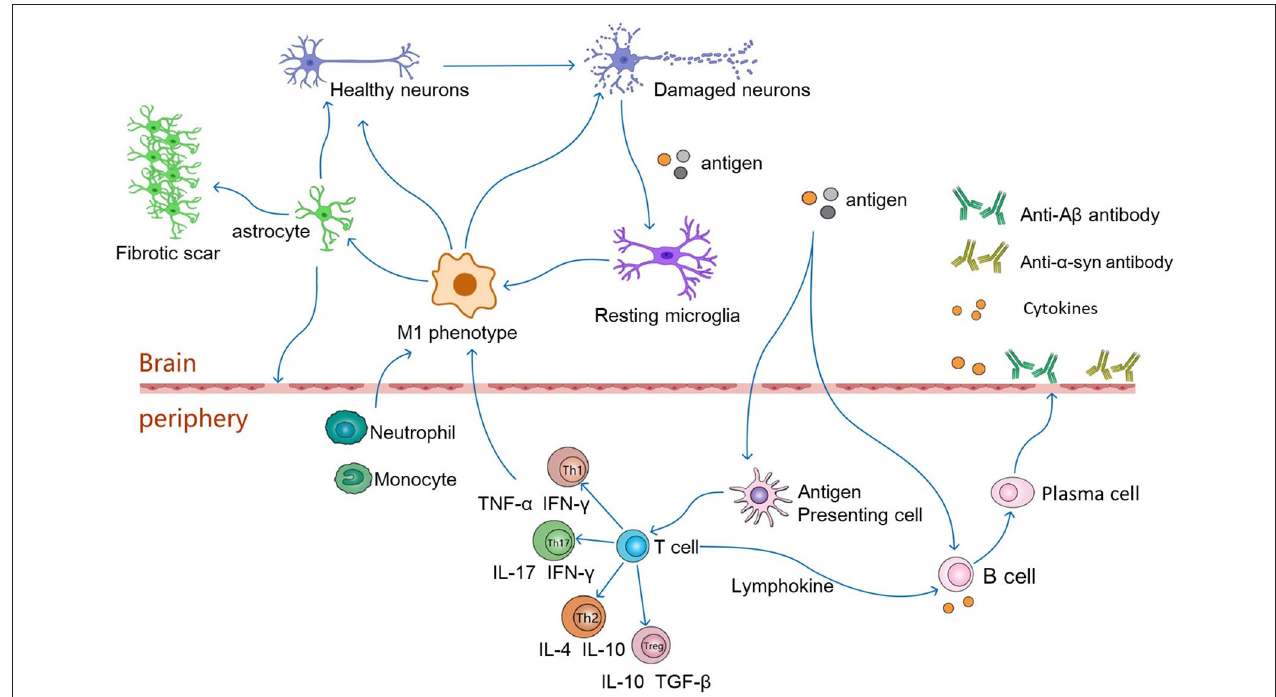
FIGURE 2 | In pathological conditions, damaged neurons release autoantigens to activate resting microglia, which differentiate into the pro-inflammatory phenotype of M1. The M1 phenotype microglia secrete pro-inflammatory factors(IL-6, TNF- α , IFN- γ ) to activate astrocytes, which induce the activation of A1 phenotype astrocytes. Reactive astrocytes contribute to the formation of glial scarring. It also leads to destruction of the BBB, which in turn leads to infiltration of CNS by peripheral immune cells. Antigens may enter peripheral lymphoid tissue, where they are presented by antigen-presenting cells to naive T cells, which differentiate into antigen-specific T effector cells (Th1, Th2, Th17 or Tregs). These cells then secrete anti-inflammatory or pro-inflammatory factors to regulate neuronal survival. Th1 and Th17 cells cross the BBB, produce neurotoxic and pro-inflammatory factors that interact with glial cells, leading directly to neuroinflammation and damage to motor neurons. Th2 and Tregs migrate from the periphery to the central nervous system and interact with glial cells to function as motor neuron protectors. In addition, antigens can directly stimulate B cells, which are activated to produce pro-inflammatory factors that travel along blood vessels to the brain and participate in neurodegeneration. Activated T cells secrete lymphokines to activate B cells, which proliferate and differentiate into plasma cells. Plasma cells can further produce cytokines and antibodies, such as anti-A β or anti- α -synuclein antibodies, which cross the blood-brain barrier into the brain to alleviate neuronal